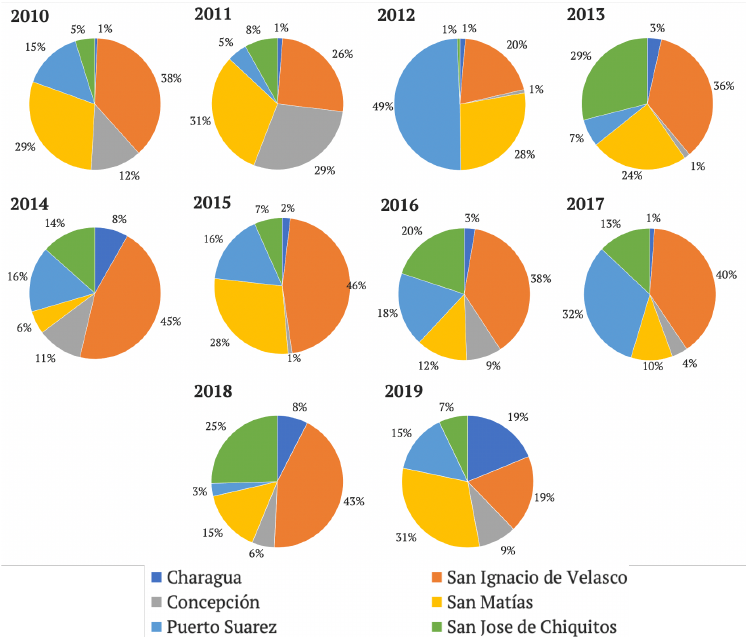
Figure 4. Proportion of burned area amongst the six most affected municipalities of the department of Santa Cruz in the period of